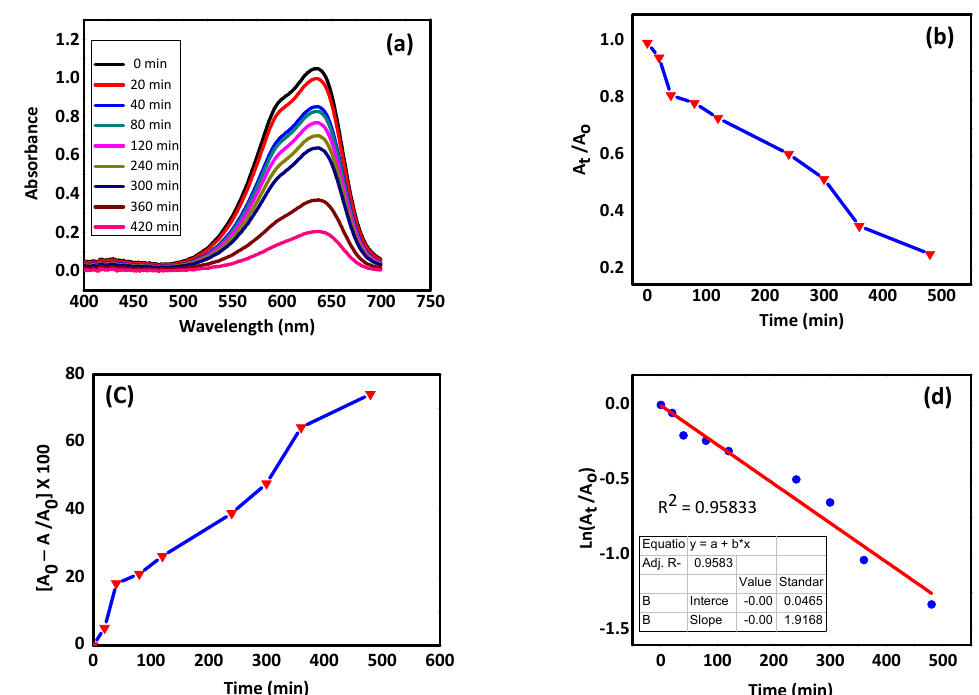
Figure 8. Summary of the degradation of Nile blue in the presence of 0.1 g of CuO–SiO 2 particles in the dark. ( a ) Variation in UV-Visible spectra/absorbance at different intervals of time, ( b ) ratio of absorbance (A t /A 0 ) versus time, ( c ) %decomposition versus time and ( d ) characteristic plot for pseudo-first-order kinetics of degradation.